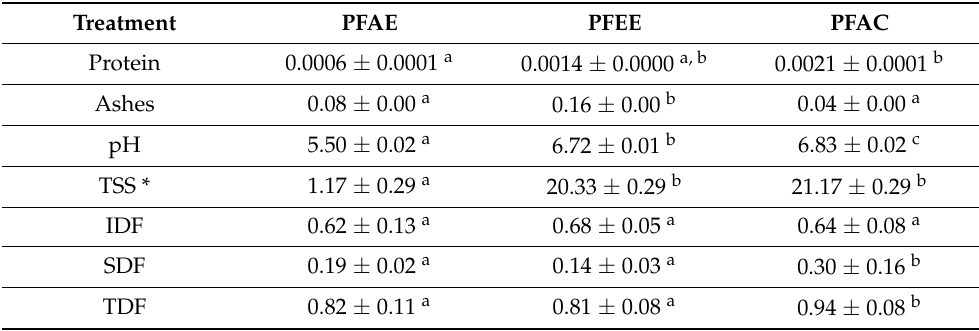
Table 1. Solvent effects on the physicochemical characteristics of extracted dietary fiber from persim- mon byproduct. Treatment PFAE PFEE PFAC Protein 0.0006 ± 0.0001 a 0.0014 ± 0.0000 a, b 0.0021 ± 0.0001 b